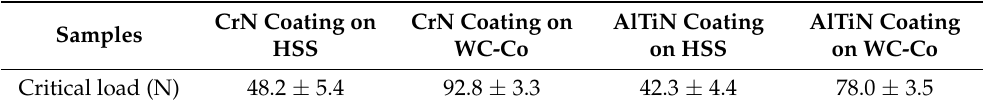
Table 4. Critical load of coated samples.